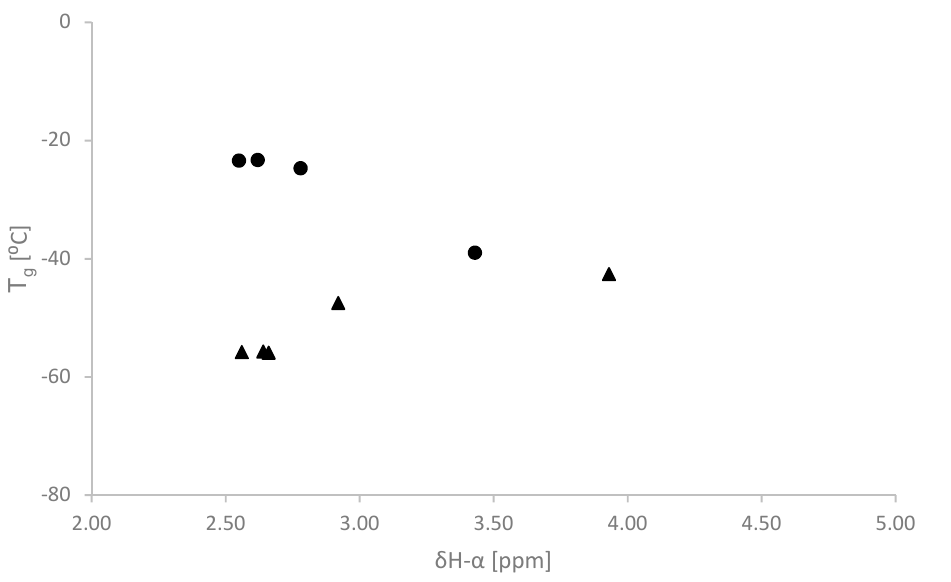
Figure 9. Plot of glass transition temperatures (T g ) vs. H- α chemical shifts for didecyldimethylammonium (circles) and tributylmethylammonium (triangles) ionic liquids.